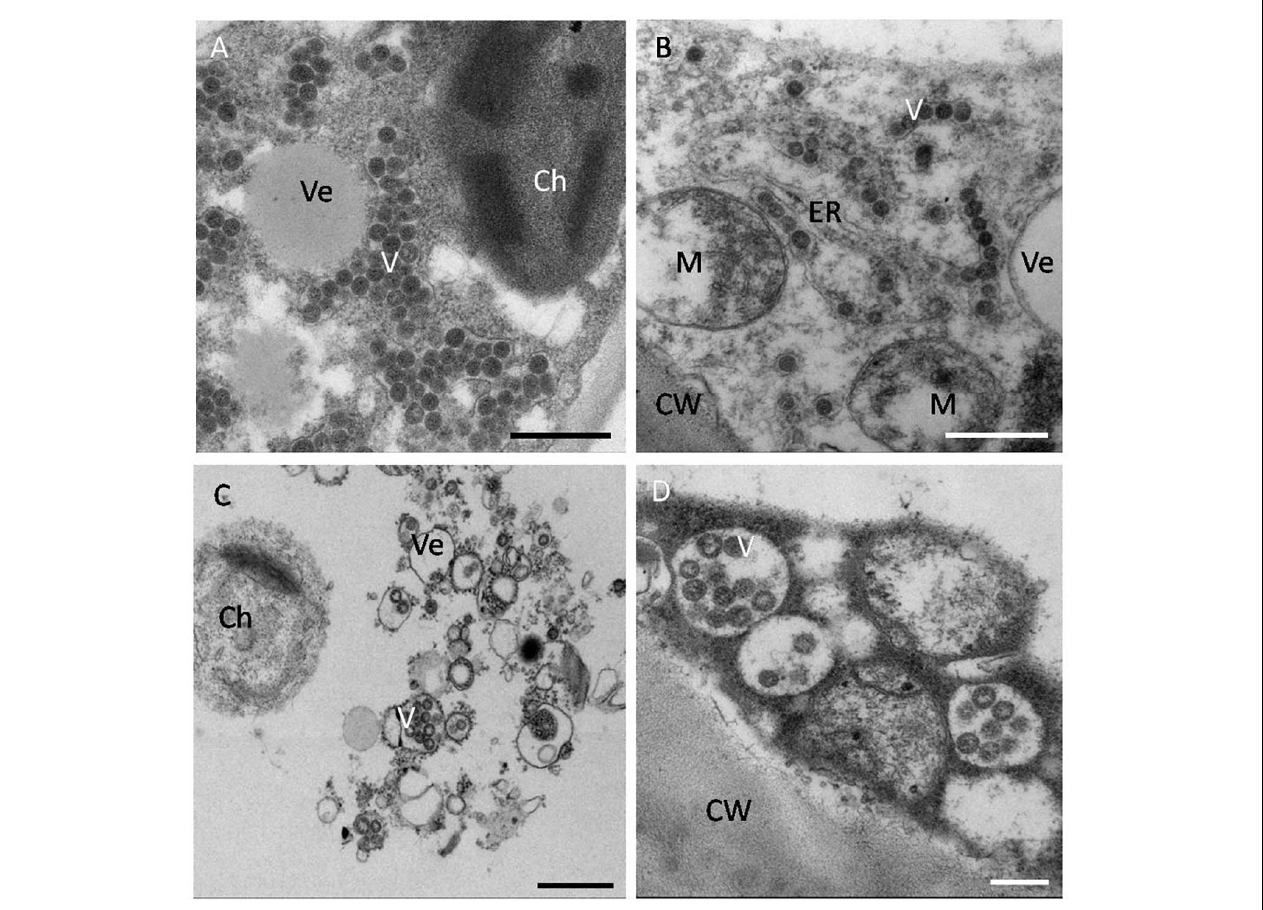
FIGURE 4 | Histopathological characteristics of orthotospoviruses in host cells. (A) TSWV virus particles clustered in the cytoplasm of a tomato leaf cell. Bar = 500 nm. (B) TZSV virus particles clustered in the endoplasmic reticulum (ER) membrane of a tomato fruit cell. Bar = 500 nm. (C) WSMoV virus particles clustered in vesicles in a tomato fruit cell. Bar = 500 nm. (D) INSV virus particles clustered in the lumen of the ER in a tomato fruit cell. Bar = 20 nm. Ve, vesicle; V, virus particle; Ch, chloroplast; M, mitochondrion; ER, endoplasmic reticulum; CW, cell